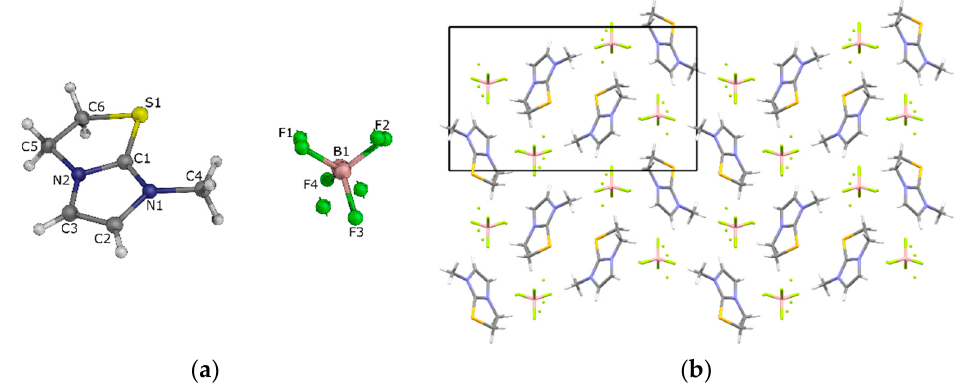
Figure 7. ( a ) Molecular structure of 4b with the atomic numbering scheme (only major parts of the disordered tetrafluoroborate ion are labeled); ( b ) projection down the crystallographic a axis. The crystal structure of 4b consists of planar heterobicyclic cations and tetrafluoroborate anions.